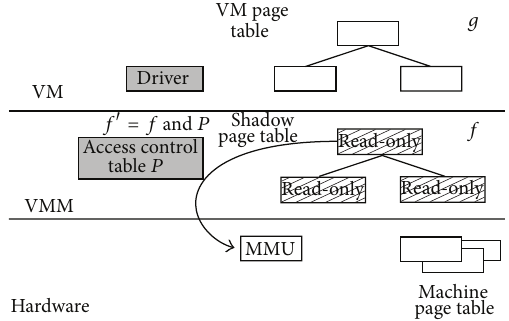
Figure 2: The implement of two-level page table translation in full virtualization